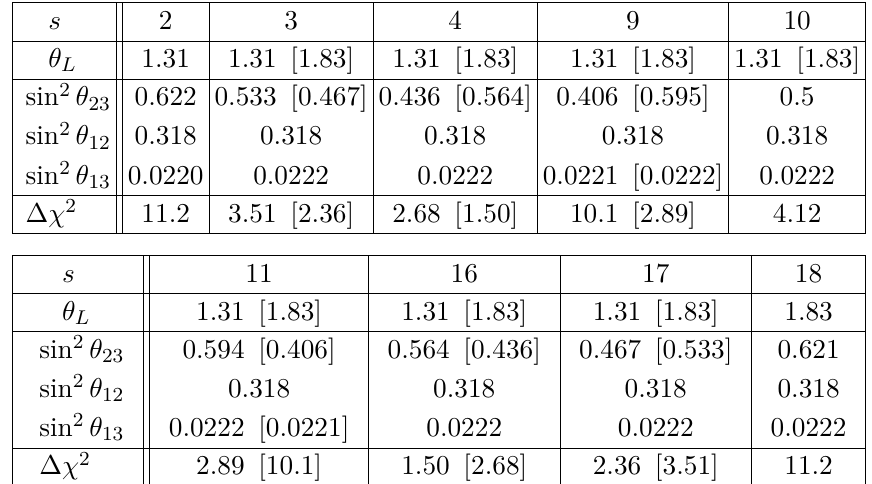
is indicated in square L